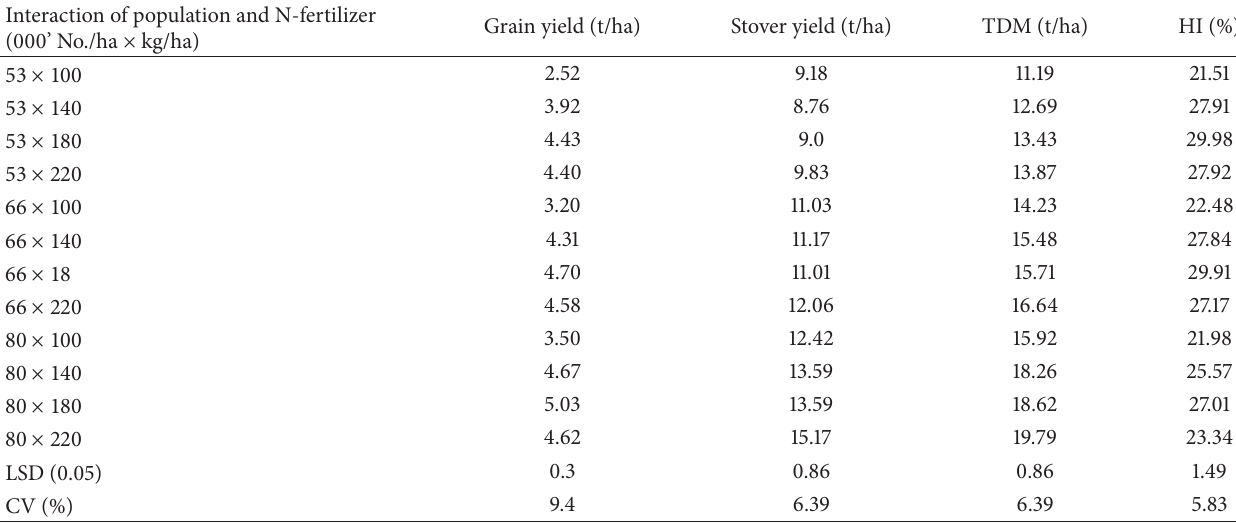
Table 3: Interaction effect of population density and N-fertilizer rates on yield and yield parameters of maize. Interaction of population and N-fertilizer Grain yield (t/ha) (000’ No./ha × kg/ha)